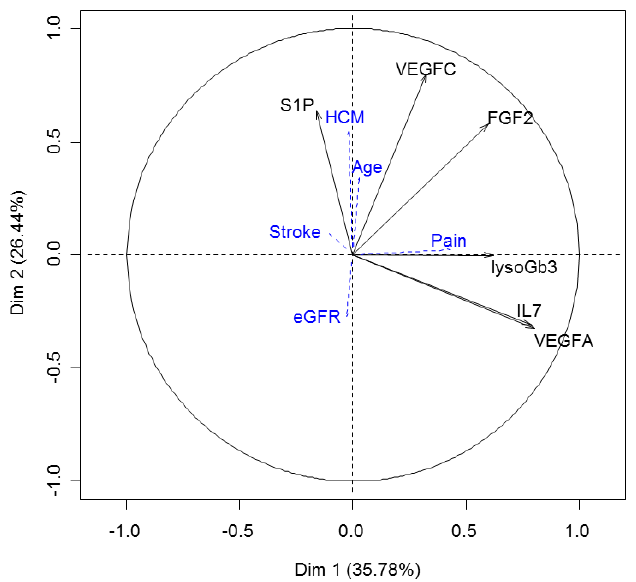
Figure 2. Variables factor map of principal component analysis including S1P, lysoGb3, FGF2, VEGF-A, VEGF-C, and IL-7 as active variables. Acral pain (Pain), hypertrophic cardiomyopathy (HCM), cerebral stroke, and estimated glomerular filtration rate (eGFR) are included as illustrative variables.